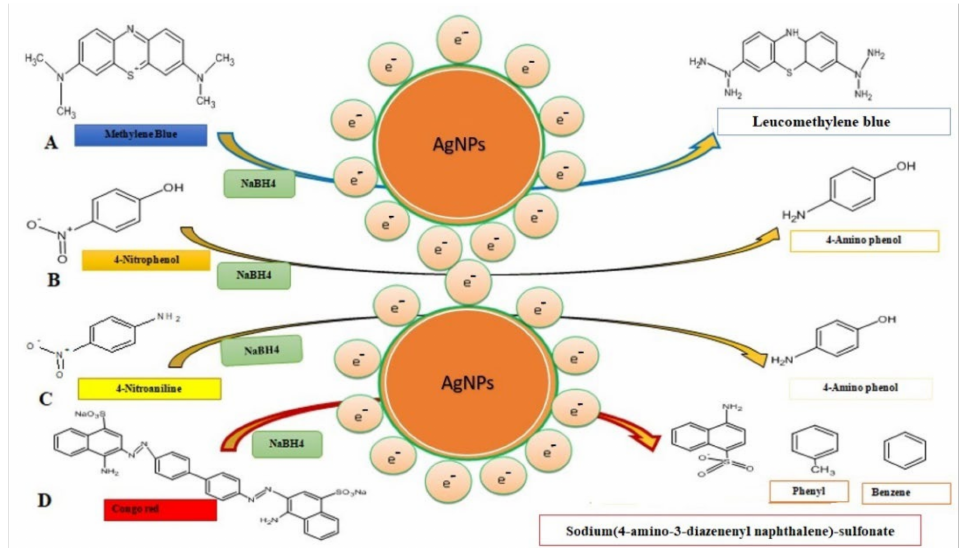
Figure 11. Degradation mechanism of toxic dyes and their catalytic degradation products through the involvement of the AgNPs. ( A ) Methylene blue, ( B ) 4-nitrophenol, ( C ) 4-nitroanaline, and ( D ) congo